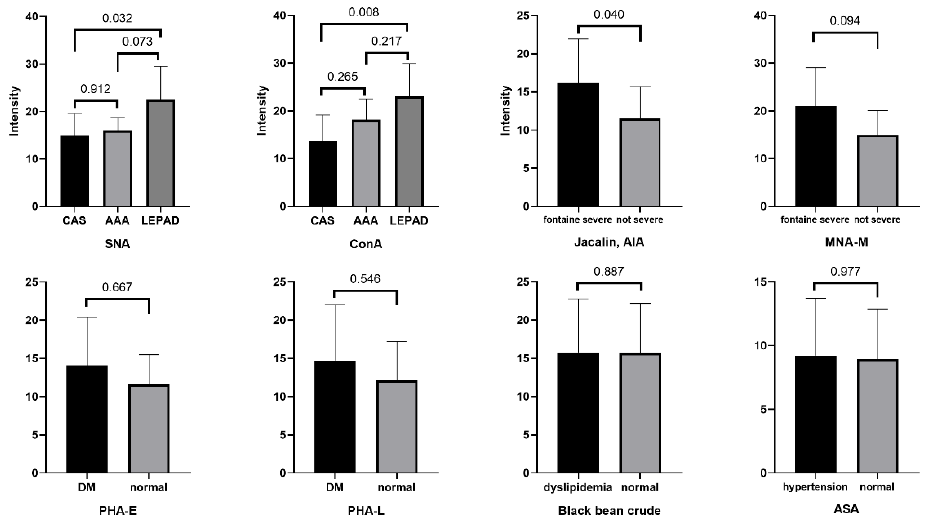
Figure 4. Lectin blot verification of selected lectins for LEPAD patients. For SNA and ConA, 7 and 8 samples in each disease group were included. For Jacalin-AIA and MAN-M, 9 samples in each subgroup were included. For Black bean crude and ASA, 12 samples in each subgroup were included. CAS, carotid artery stenosis; AAA, abdominal aortic aneurysm; LEPAD, lower-extremity peripheral artery disease; DM, diabetes mellitus. Details of lectins and their binding glycan structures can be seen in the Supplementary files.